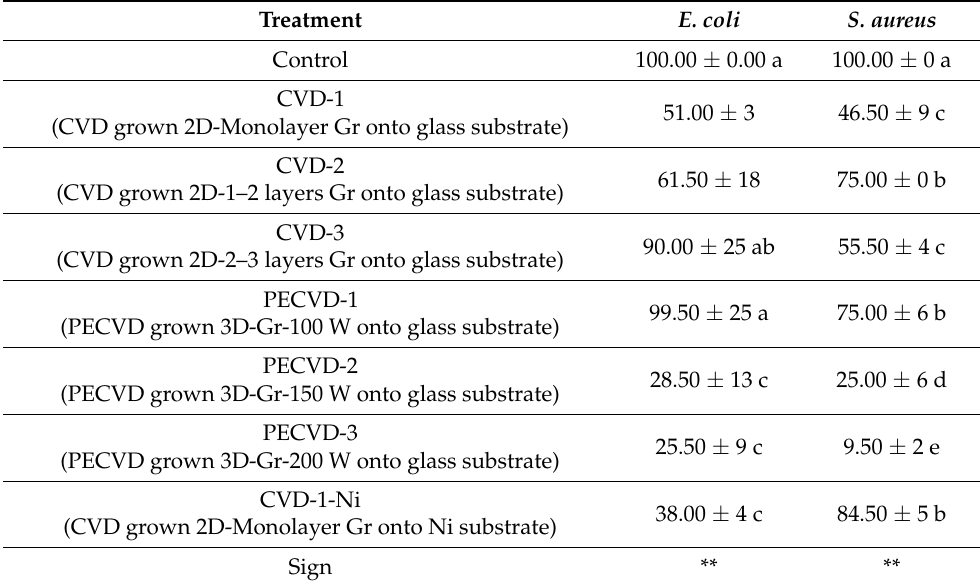
Table 1. Variance analysis of the effect of graphene treatments on the cell viability (%) of E. coli and S.